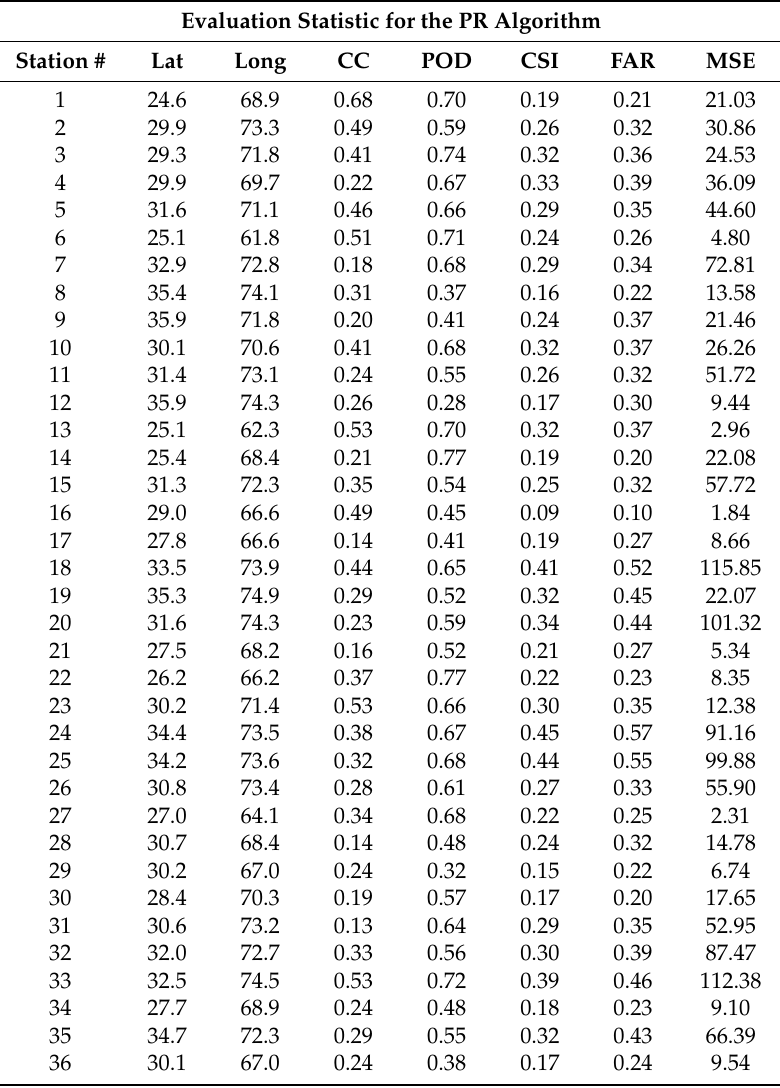
Table 1. Evaluation Statistic for the precipitation radar (PR) algorithm at each selected gauge. Evaluation Statistic for the PR